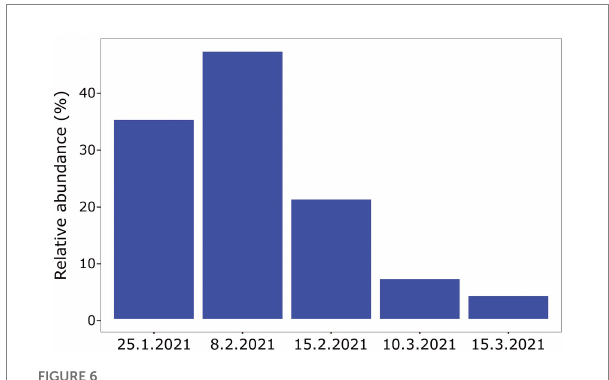
FIGURE 6 Relative abundance of Streptococcus sp. isolated from surrounding seawater samples, season 2021.